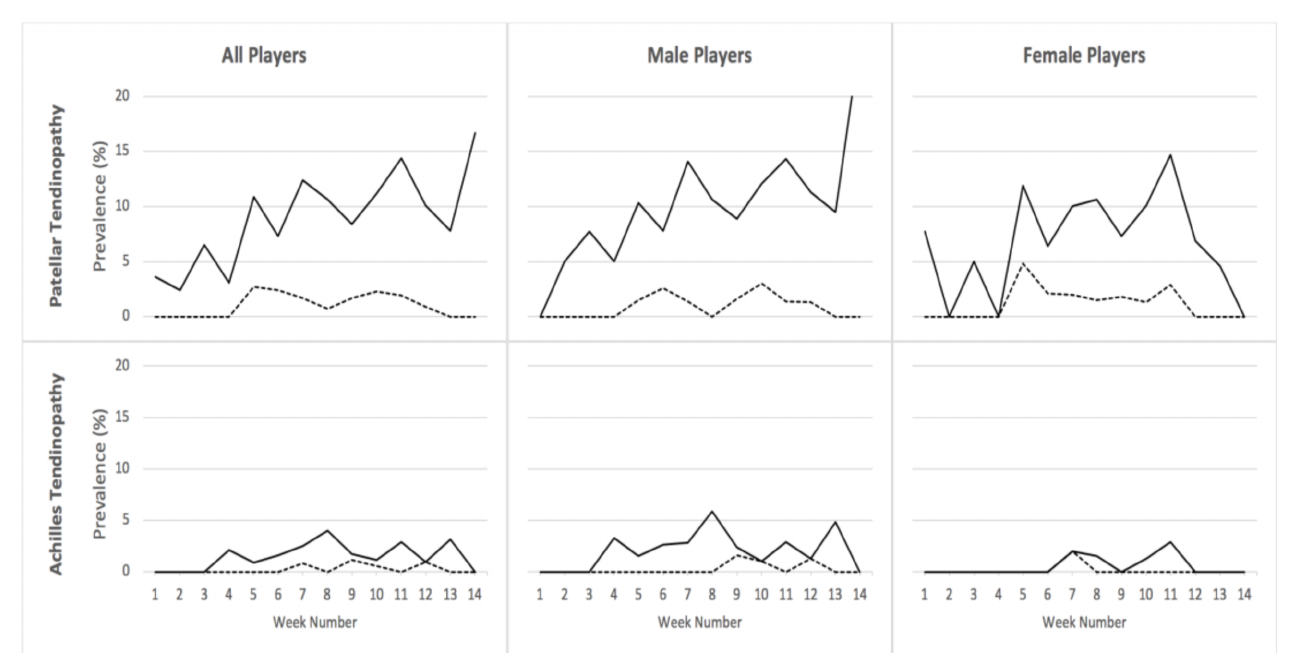
Figure 2. Prevalence of all patellar and Achilles tendinopathy (straight line, _____ ) and substantial patellar and Achilles tendinopathy (broken line, —–) in all players, male and female players, over a 14-week follow-up period. Participant numbers varied from 12 players in week 14 to 178 players in week 9. Week numbers were sequentially aligned for both school and club seasons; a 1-week Christmas break (week 4) was absent for the school season, i.e., week 4 prevalence is based on the club season only. Substantial tendinopathy connotes tendinopathy leading to moderate or severe reductions in training volume or performance, or an inability to